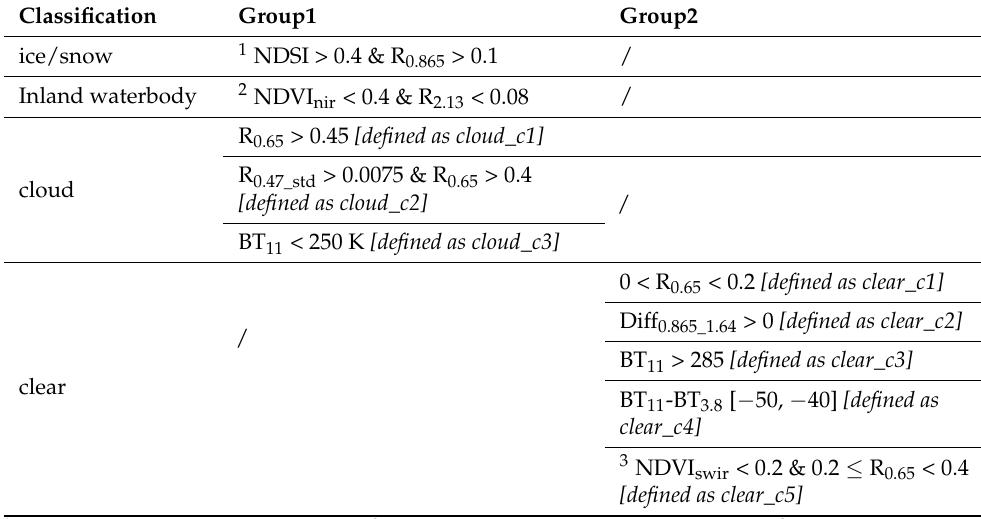
Table 2. Details thresholds for MHAM algorithm using FY3D/MERSI-II